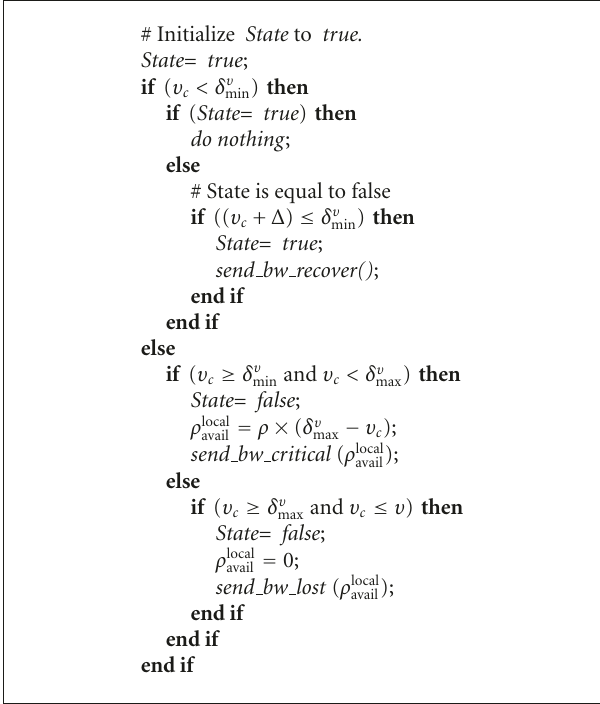
Algorithm 1: IAC/O: Estimation of ρ neigh